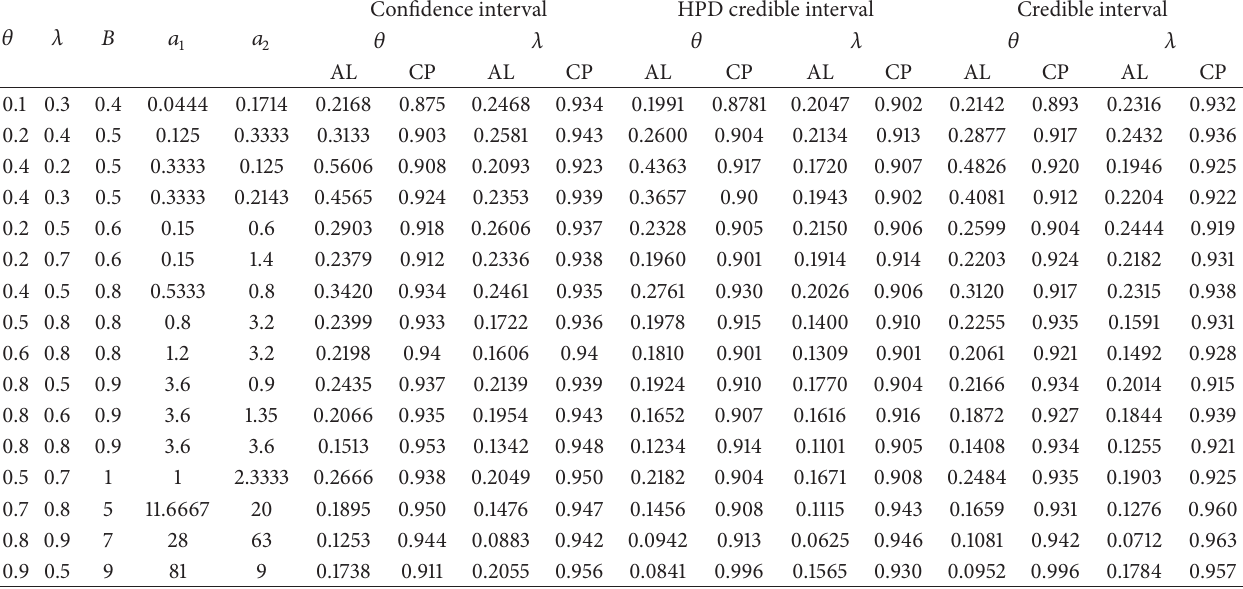
Table 10: Confidence, credible, and HPD credible intervals for the